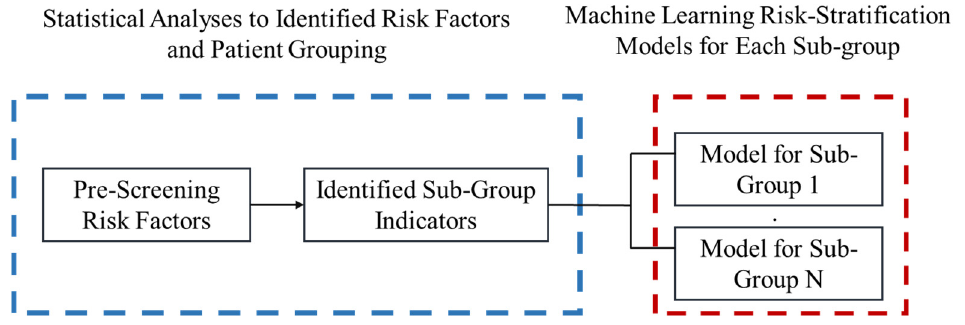
Figure 1. Diagram for proposed Heuristic .